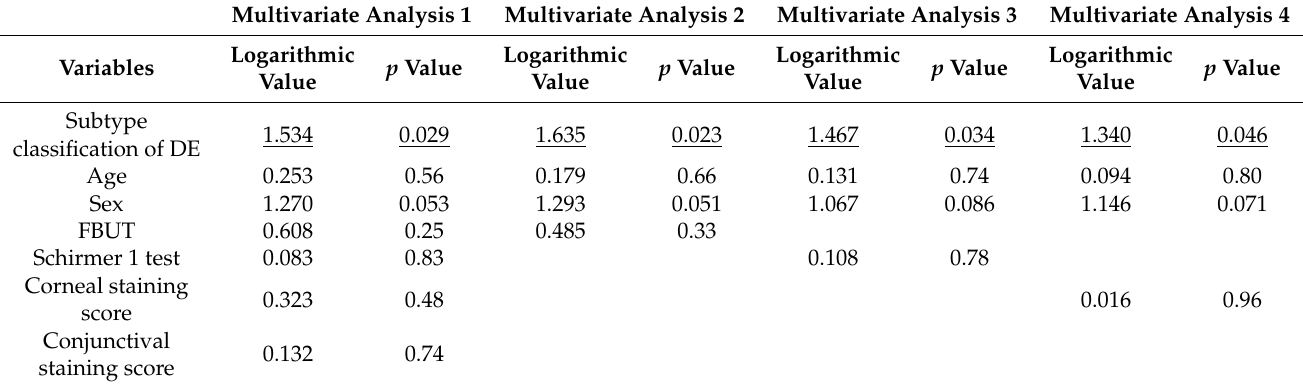
Table 4. Multivariate analysis of objective findings for pain degree by the least squares method. Multivariate Analysis